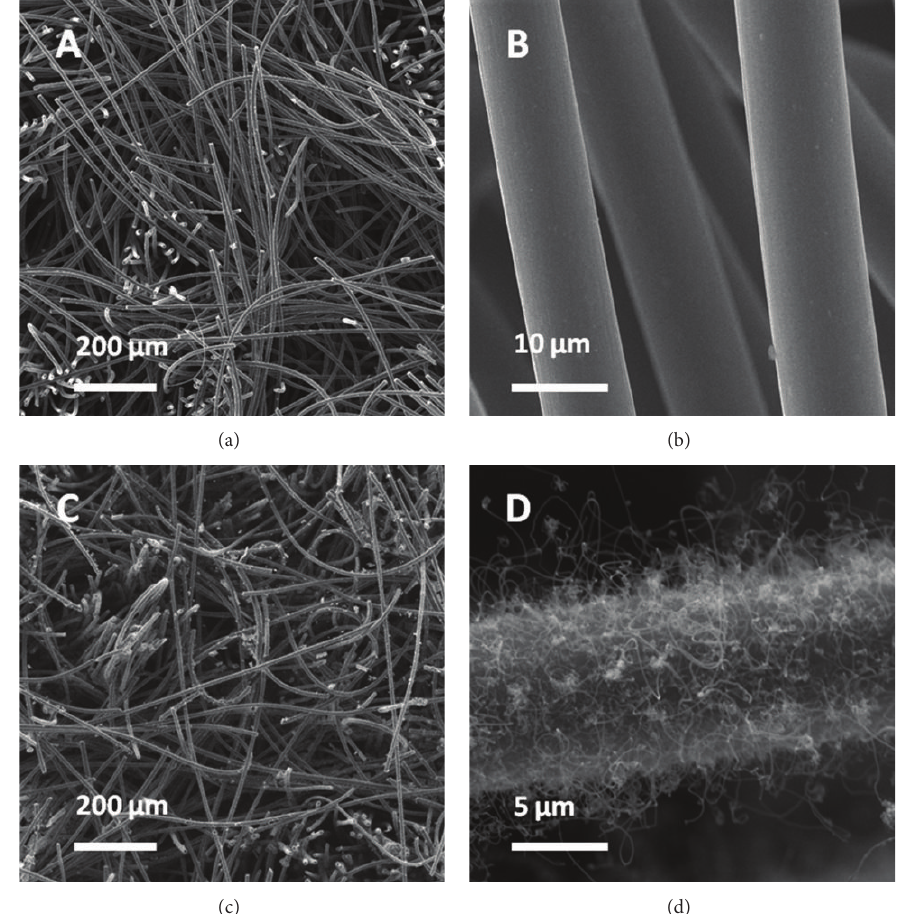
Figure 1: SEM images of ((a) and (b)) GF and ((c) and (d))